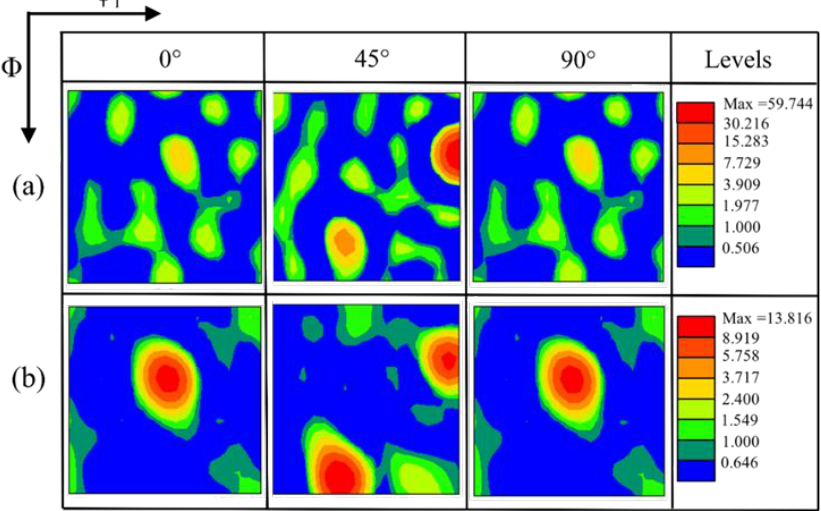
Figure 12. Orientation distribution function diagram of composite extruded by porthole die: ( a ) welding zone; ( b ) matrix zone.